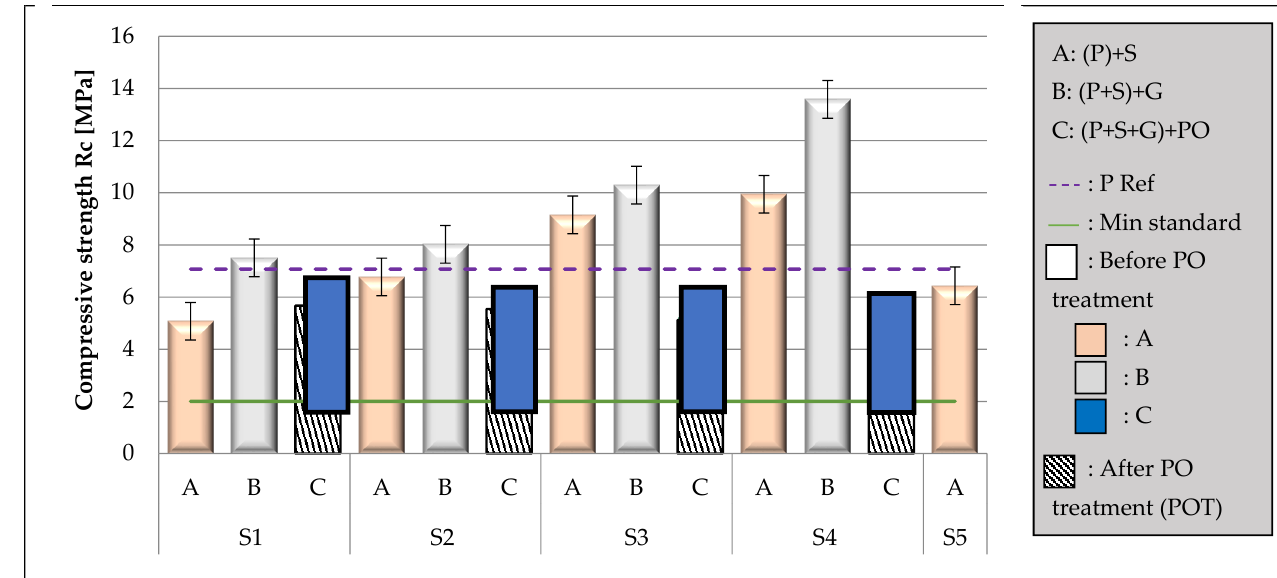
Figure 8. Variation in compressive strength of composites in the different mixing plans.